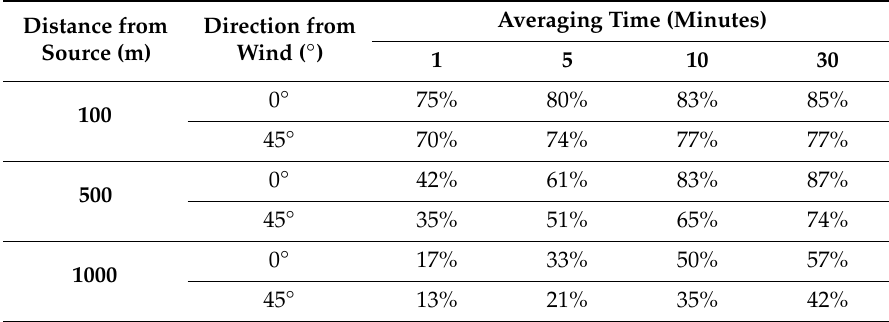
Table 3. Comparison of intermittency between the along-wind (0 ◦ ) condition and 45 ◦ from the wind direction.